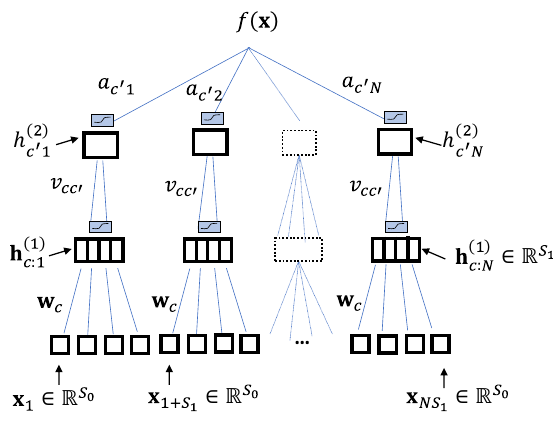
Fig. 7 | A 3 layers CNN architecture. An illustration with non-overlaping strides. The black squares represent the strides window in each